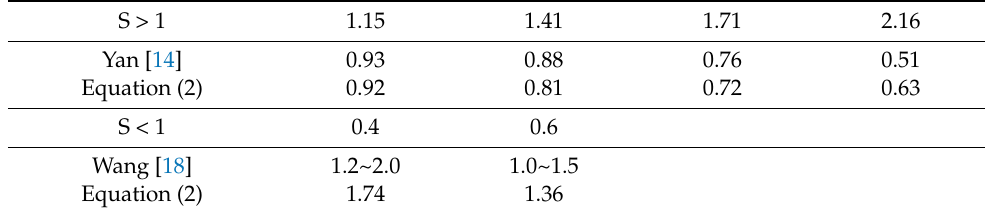
Table 4. Comparison of impact force results of rockfall with different shape